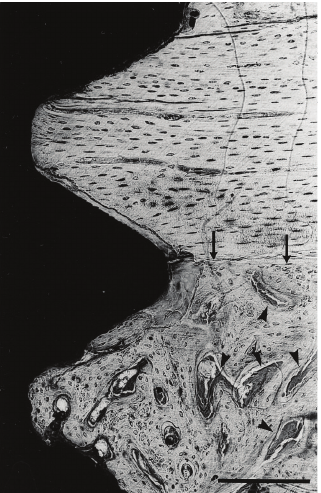
Figure 5: H 2 O 2 treated implant after 1 week. An intense remodeling activity (arrow-heads) is observed immediately located beneath the corticomedullary border (arrows). Bar = 200 𝜇